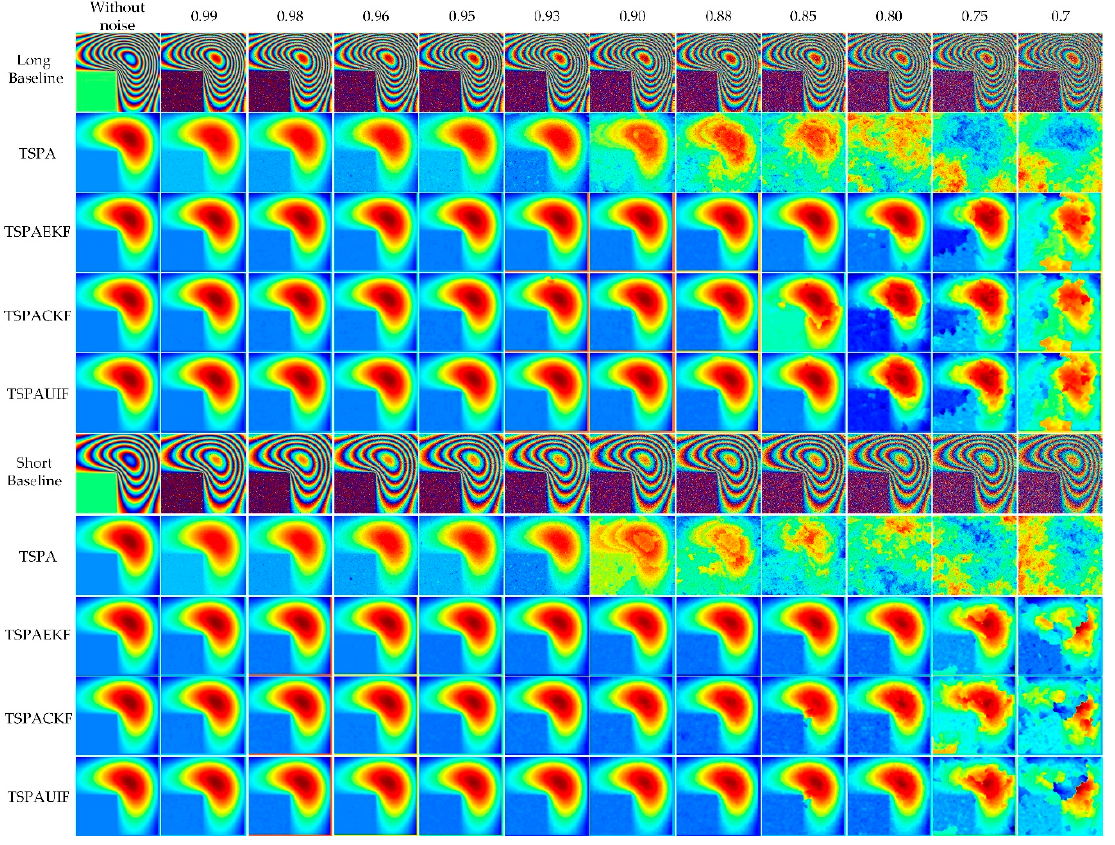
Figure 6. Robustness analysis using simulated data of Figure 4( b,c ) with different methods.